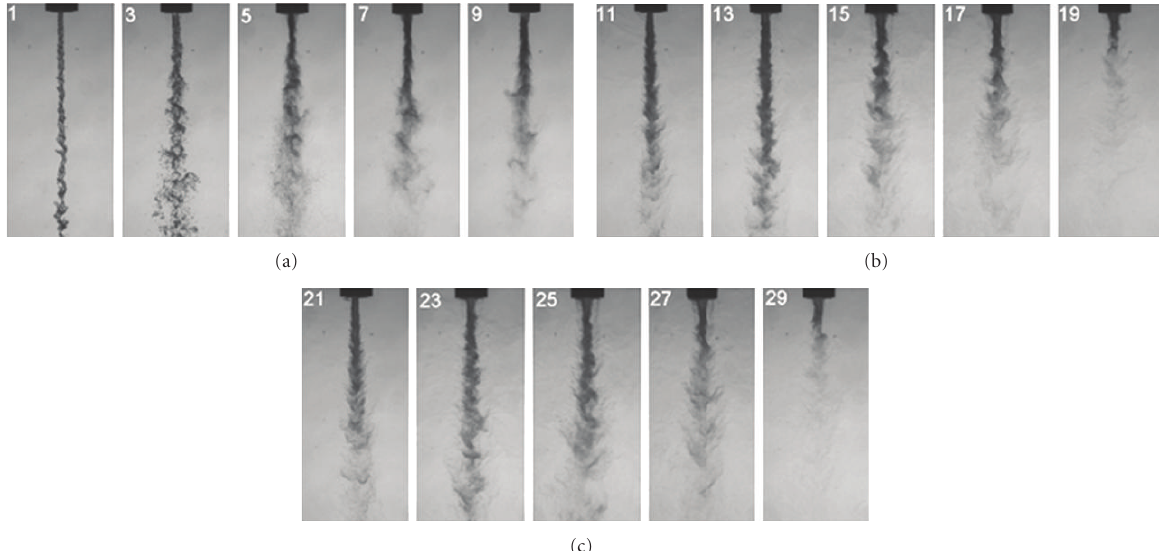
Figure 18: Images of a coaxial jet at approximately the same inner-jet mass flow rates ( ∼ 275mg/s). Columns are at about the same outer- annular-jet mass flow rates. For each row, the annular mass flow rate starts at a zero value to 2800 mg/s and increases from the left column to the right. The chamber pressure levels for images 1–9 are subcritical ( ∼ 1.41MPa), for 11–19 are near-critical ( ∼ 3.46MPa), and for 21–29 are supercritical ( ∼ 4.77 MPa). Inner-and outer-tube flow average temperatures at injector exit are 170 K and 112 K, respectively. Davis and Chehroudi